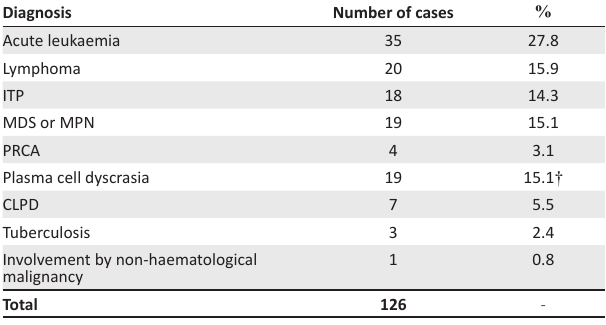
TABLE 2: The diagnostic yield of bone marrow